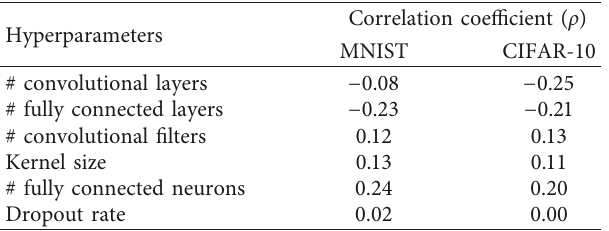
Table 4: Correlation between model hyperparameters and test accuracy.